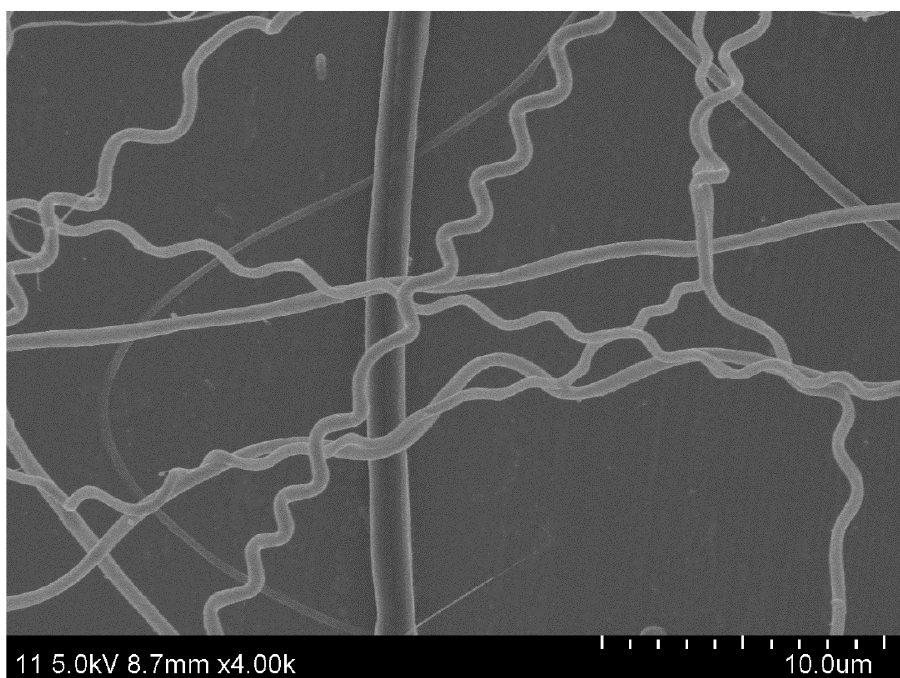
Figure 2. The SEM image of the helical-fiber nonwoven sample.